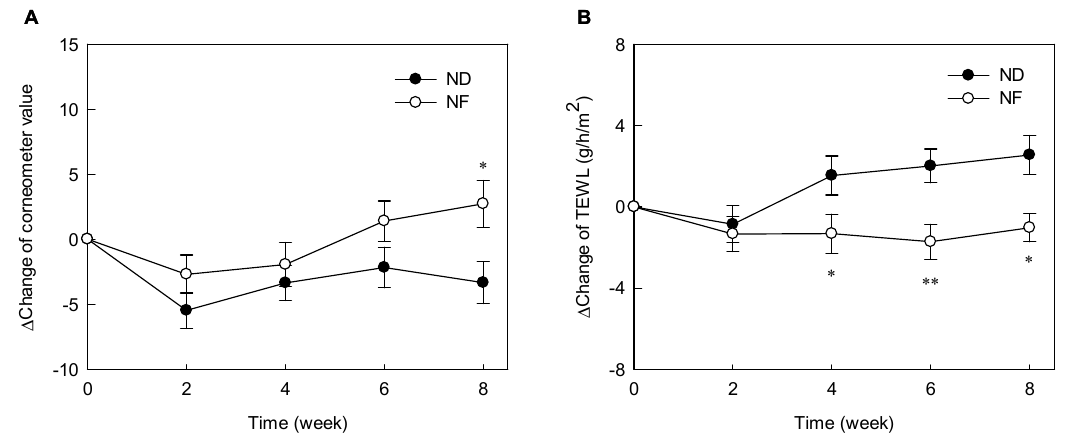
Figure 1. Effects of serum cosmetics containing galacto-oligosaccharides (GOS) on water holding capacity ( A ) and transepidermal water loss (TEWL) ( B ) from baseline after 8 weeks of treatment in healthy adults. The asterisks indicate significant differences (* p < 0.05 and ** p < 0.01) between the NF and the ND groups at the indicated week. The p of two-sided independent t-test method was displayed, and all data are reported as mean ± standard error of the mean. ND (control serum); NF (cosmetic serum containing GOS).